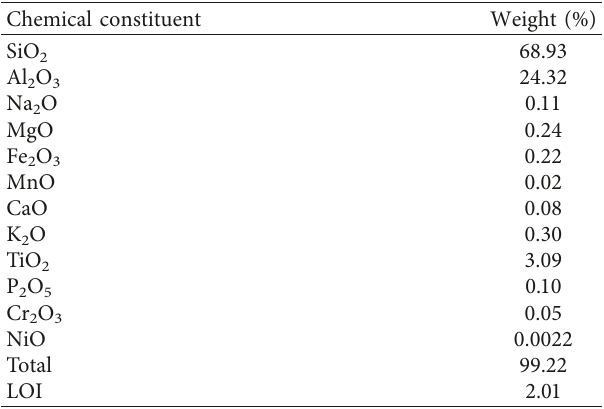
Table 1: XRF chemical constituent present in LBK